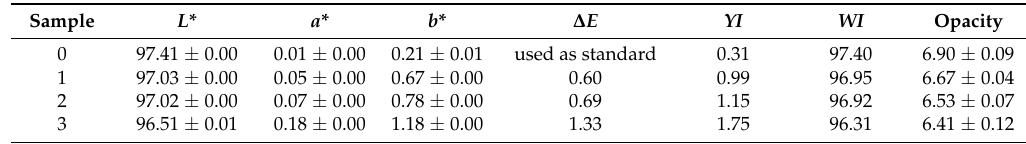
Figure 6. The results of microscopic examination of the films: ( A ) pure PLA film ( B ) 0.025% PLA/melanin film ( C ) 0.05% PLA/melanin film ( D ) 0.2% PLA/melanin film. Table 2. Color parameters ( L *, a *, b *), ∆ E , yellowness index ( YI ), whitening index ( WI ) and opacity of pure PLA and PLA/melanin modified